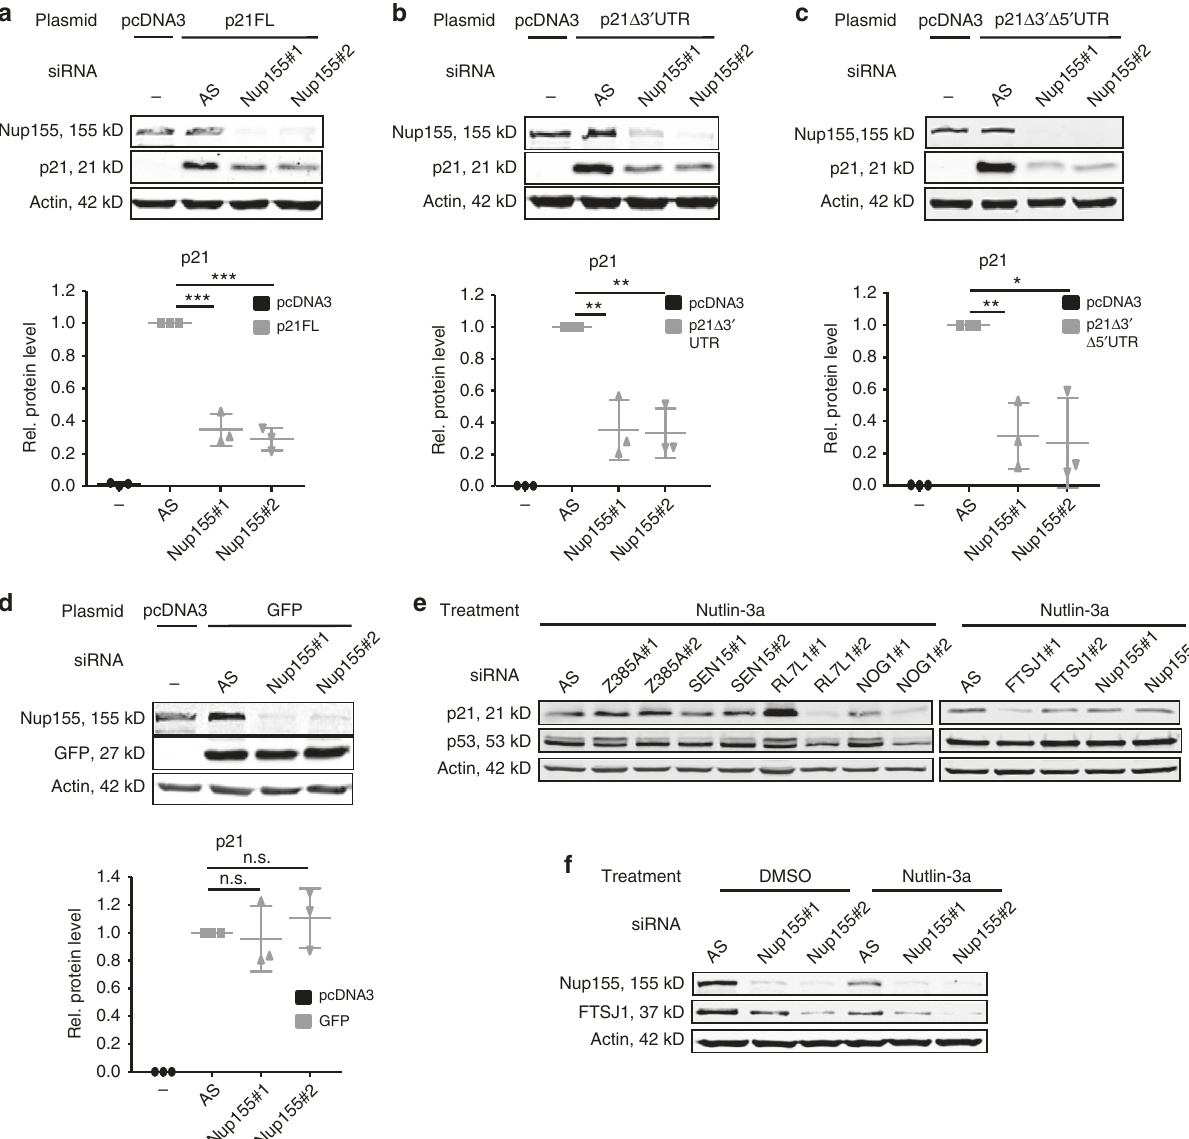
respectively). To substantiate this observation, we treated another p53 wild-type containing cancer cell line (Sk-Hep1) with Nutlin- 3a for 24 and 48 h. Figure 6a demonstrates also in Sk-Hep1 cells a gradual decrease of Nup155 and FTSJ1 protein (upper and middle panel) upon p53 accumulation. The decrease of Nup155 and FTSJ1 proteins were paralleled by reduced nascent NUP155 and FTSJ1 mRNA suggesting transcriptional repression by p53